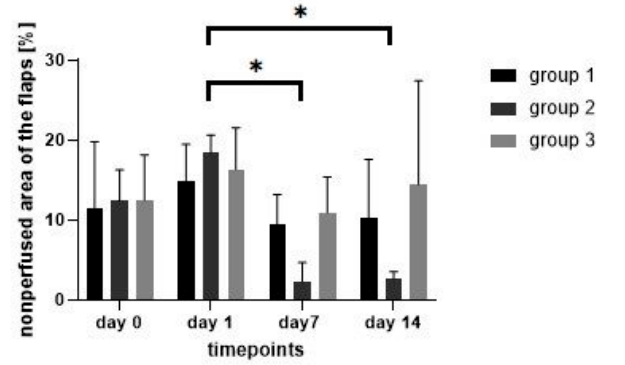
Figure 7. Nonperfused areas of the flaps in the indocyanine green angiography over time in the different treatment groups. * showing statiscally significant differences ( p ≤